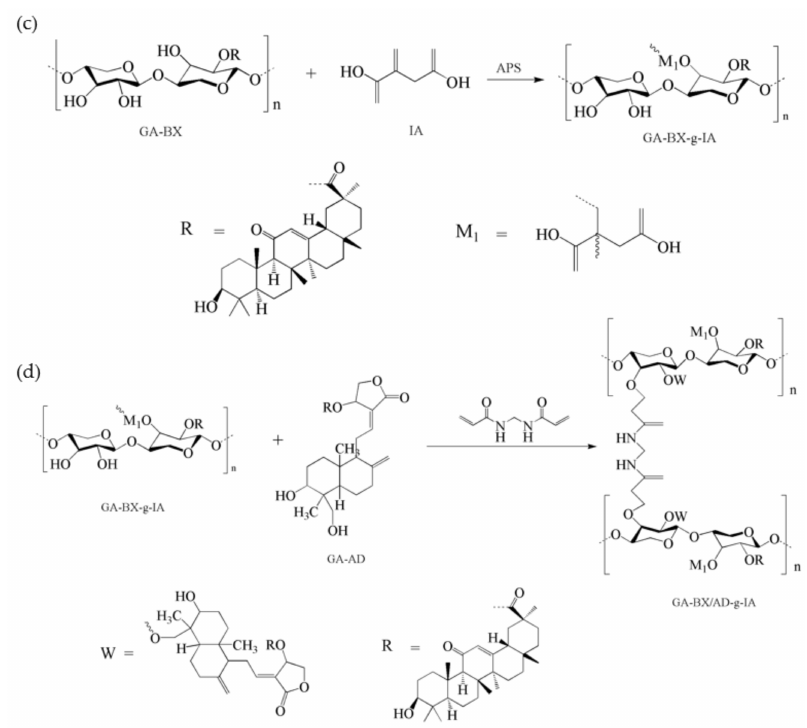
Figure 1. ( a ) The reaction mechanism of glycyrrhetinic acid chloride. ( b ) The reaction mechanism of GA- BX/AD. ( c ) The reaction mechanism of GA-BX-g-IA. ( d ) The reaction mechanism of